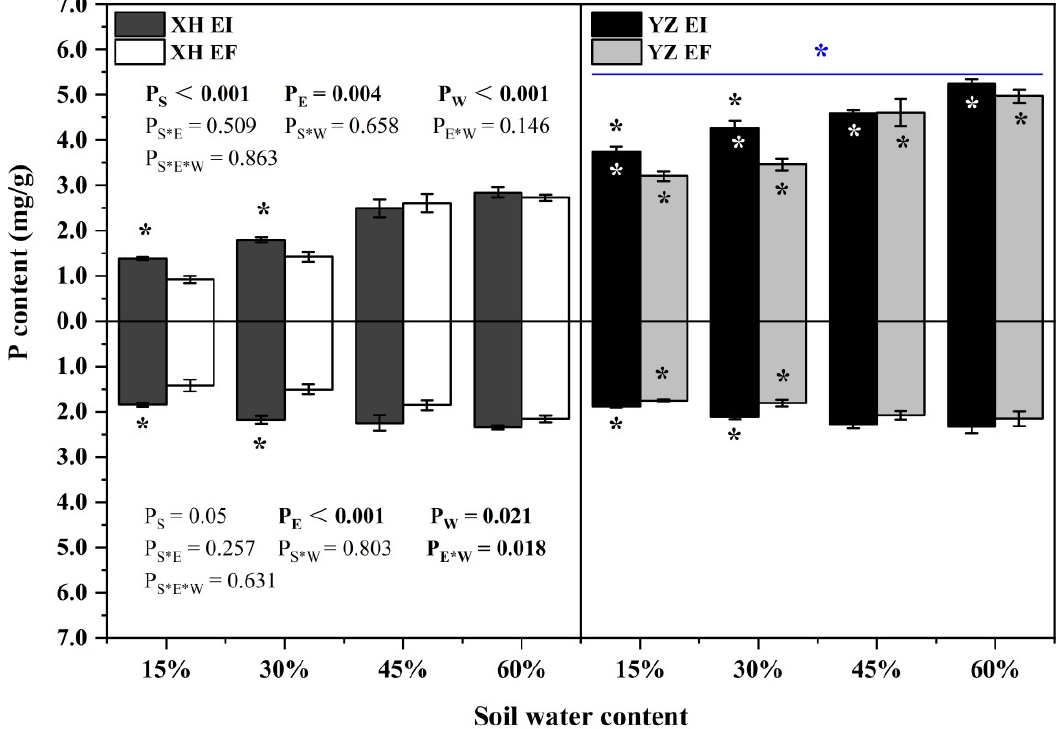
Figure 9. The P content of A. inebrians seedlings growth shoots and roots from XH(W) and YZ(D) seeds under various soil water content (mg/g). Upwards and downwards bars represent the value of shoot and root part, respectively. The asterisk (*) above/below error bars means significant dif- ference ( p < 0.05) between EI and EF under the same soil water content. White/black * in the black/gray bars indicates significant difference ( p < 0.05) between Xiahe and Yuzhong maternal habitat type of EF/EI grasses. The blue * above/below full blue line indicates significant difference ( p < 0.05) between Xiahe and Yuzhong maternal habitat type. The shoot C:N ratio was significantly affected by endophyte ( p < 0.001), water con- tent ( p < 0.001), seed origin × endophyte ( p < 0.001), endophyte × water content ( p = 0.002), seed origin × water content ( p = 0.022) and endophyte × water content × seed origin ( p = 0.046) (Table S4). The shoot C:N ratio of XH(W)EI DHG was lower than XH(W)EF DHG significantly ( p < 0.05) at 30% SWC by 6.51%. Endophyte decreased the shoot C:N ratio from the YZ(D) site at 15% and 30% SWC significantly ( p < 0.05), with a decrease of 21.83% and 19.85%, respectively. The shoot C:N ratio of YZ(D)EI DHG was higher than XH(W)EI DHG ( p < 0.05) at 60% SWC significantly by 14.60%. The shoot C:N ratio of YZ(D)EF DHG was also higher than XH(W)EF DHG ( p < 0.05) at 15%, 30%, and 60% SWC, with a relative increase of 30.08%, 20.00%, and 23.43% (Figure 10). The root C:N